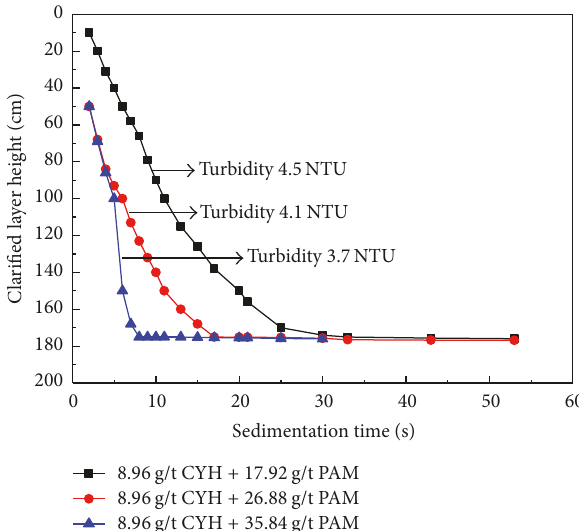
Figure 5: Effect of coagulation at different PAM dosage.